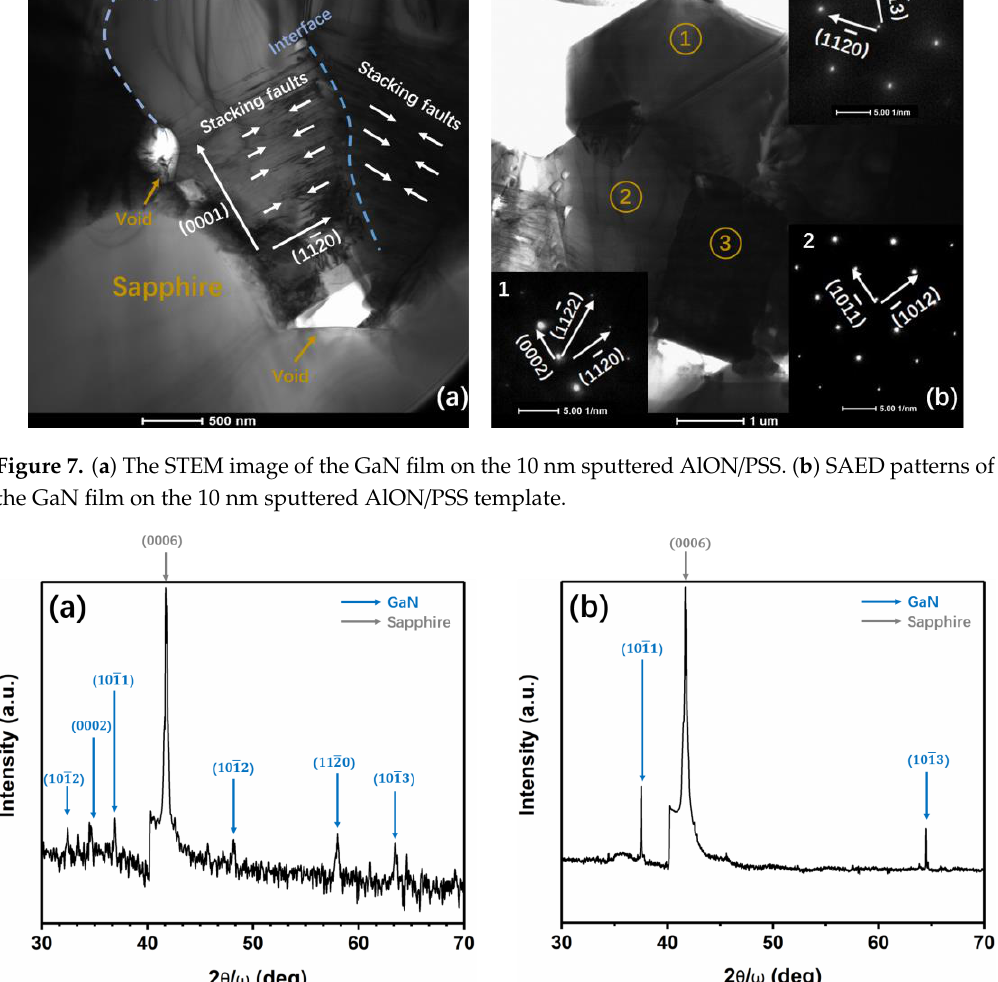
Figure 8. A symmetric (0004) 2 θ / ω scan for ( a ) the GaN film on 10 nm sputtered AlON / PSS and ( b ) the GaN film on 10 nm sputtered AlON / PSS at stage 2.